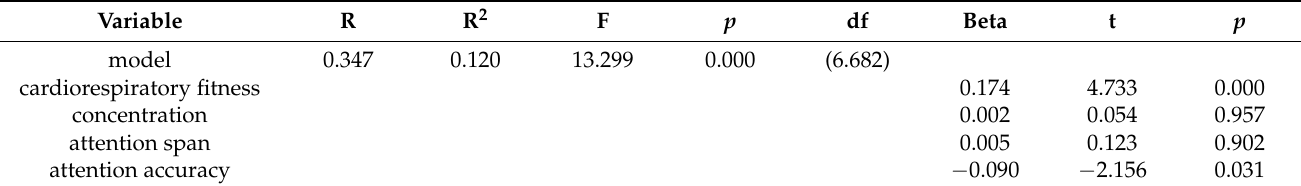
Table 3. Results of multiple linear regression model for predicting psychological well-being.